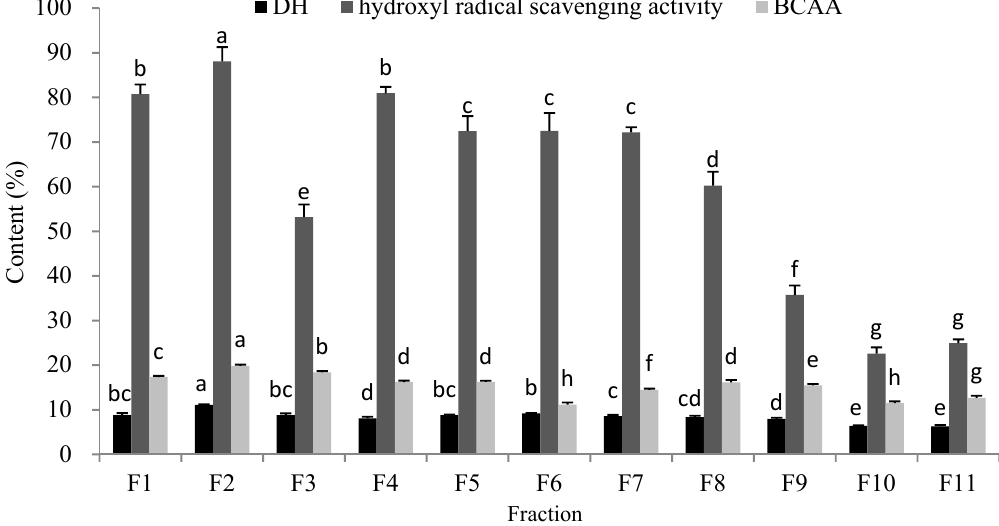
Figure 4. The contents of the parameters of different fractions from OP-III. Different letters indicate significant differences between groups ( p < 0.05). Table 5. The peptide sequences of